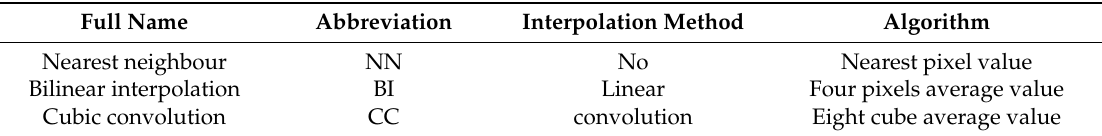
Table 3. Various types of resampling techniques.